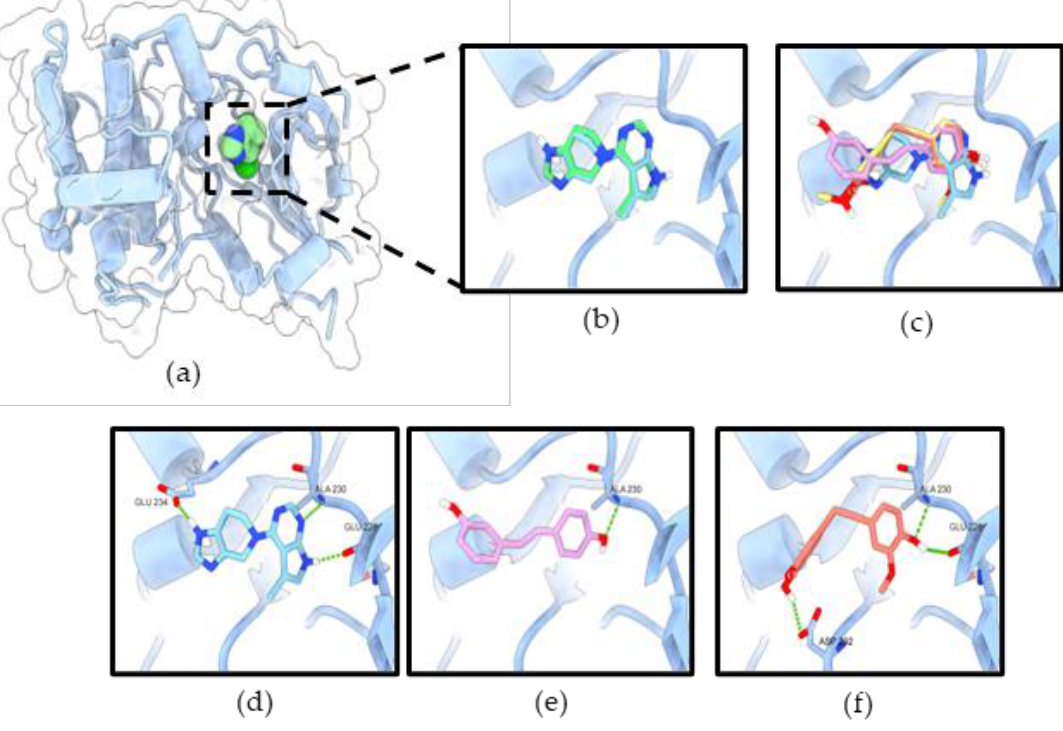
Figure 10. RD2 inhibits Akt activity via interaction with the ATP-binding site of Akt-1. ( a ) Co-crystal structure of CQW (ATP-competitive inhibitor) in Akt-1 (PDB 3CQW); ( b ) the original ligand (green) and redocking (blue); ( c ) superimposition of CQW, resveratrol (pink), and RD2 (red); the binding mode of compounds CQW ( d ), resveratrol ( e ), and RD2 ( f ) in the ATP-binding site of Akt-1. The green dashed lines indicate hydrogen bonds. Table 2. The binding affinities of ligands docked with the allosteric site of Akt-1 . Compound